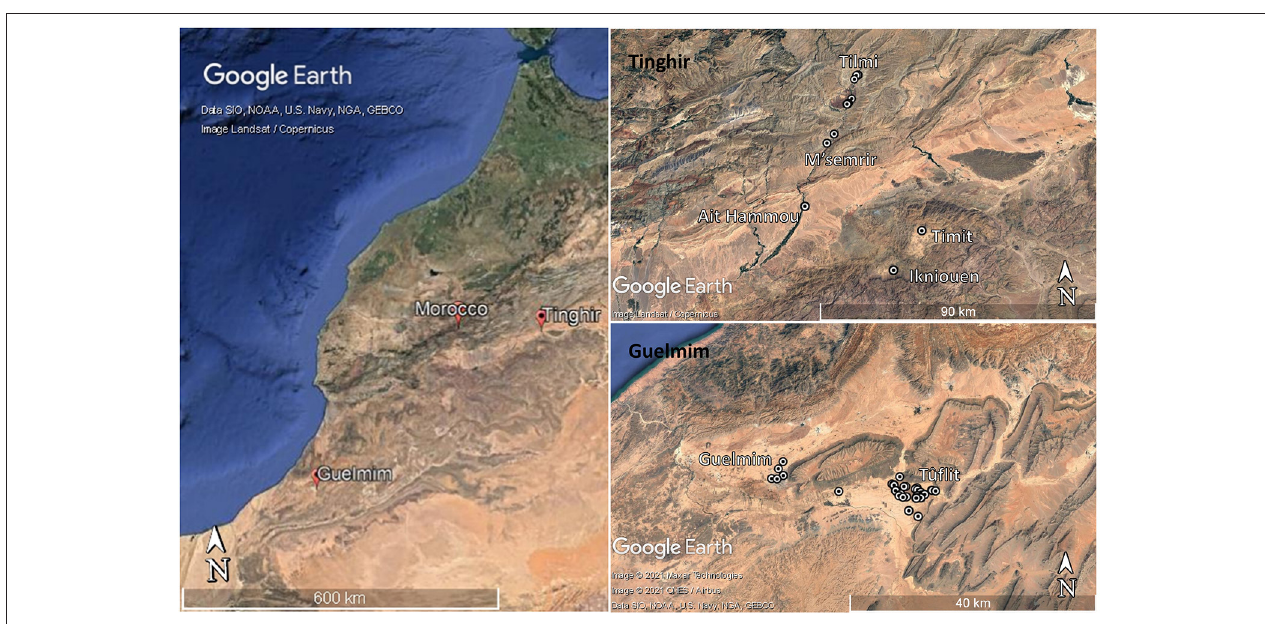
FIGURE 1 | Location of the two study areas in Morocco. White dots with black points indicate location of surveys (maps created using Google Earth).